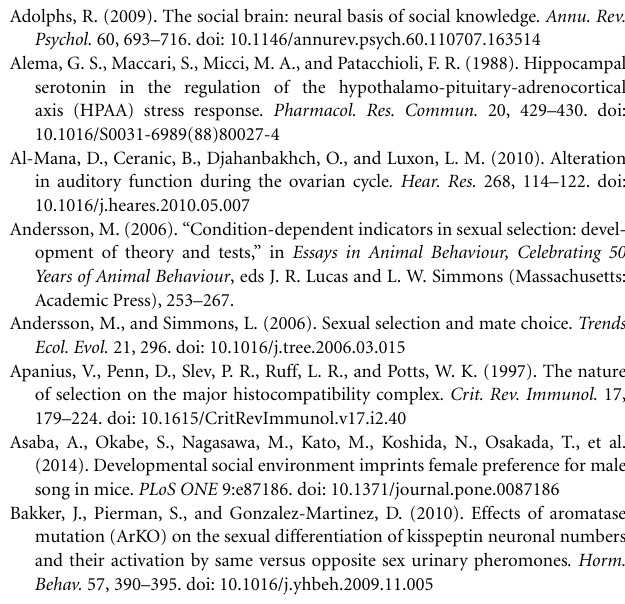
background-dependent male USVs and pheromones contribute to inbreeding avoidance. Abbreviations: gonadotropin-releasing hormone (GnRH), luteinizing hormone (LH), ultrasonic vocalization